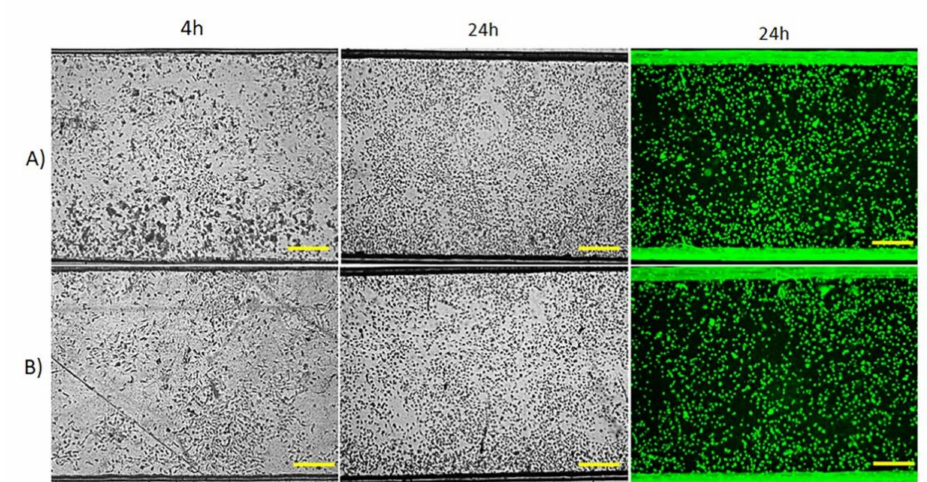
Figure 5. Microchannel of laminated microchips filled with HUVEC at 5 × 10 6 cells mL –1 , after 4 h and 24 h of incubation at 37 ◦ C with RPMI-1640 culture medium flow rate 2 µ L min − 1 . The cell viability was detected by the mixture of AO/EB staining. Green dots correspond to live cells and red-orange dots correspond to dead cells when present. ( A ) in PET microchip and ( B ) in the polyester-vinyl microchip. Scale bar = 200 µ m.